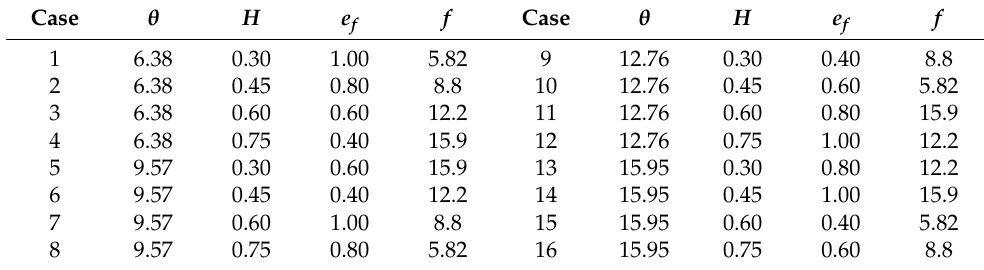
Table 6. Orthogonal experiment design table.